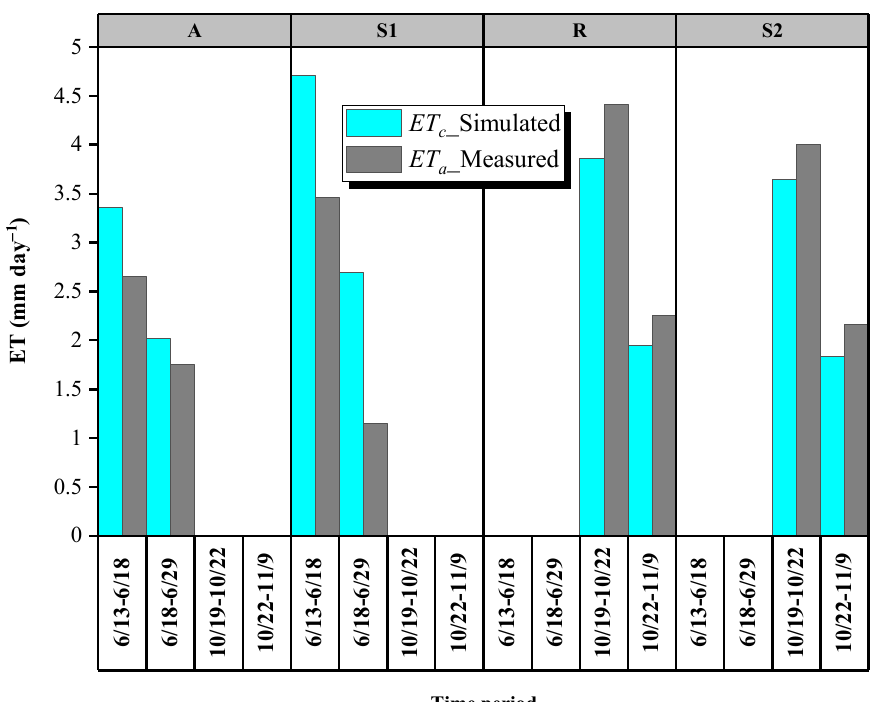
Figure 8. Comparison of measured ET a and simulated ET c under different treatment in two seasons. (6/13–6/18 and 6/18–6/29 time periods were chosen for the first season, 10/19–10/22 and 10/22–11/9 time periods were chosen for the second season).